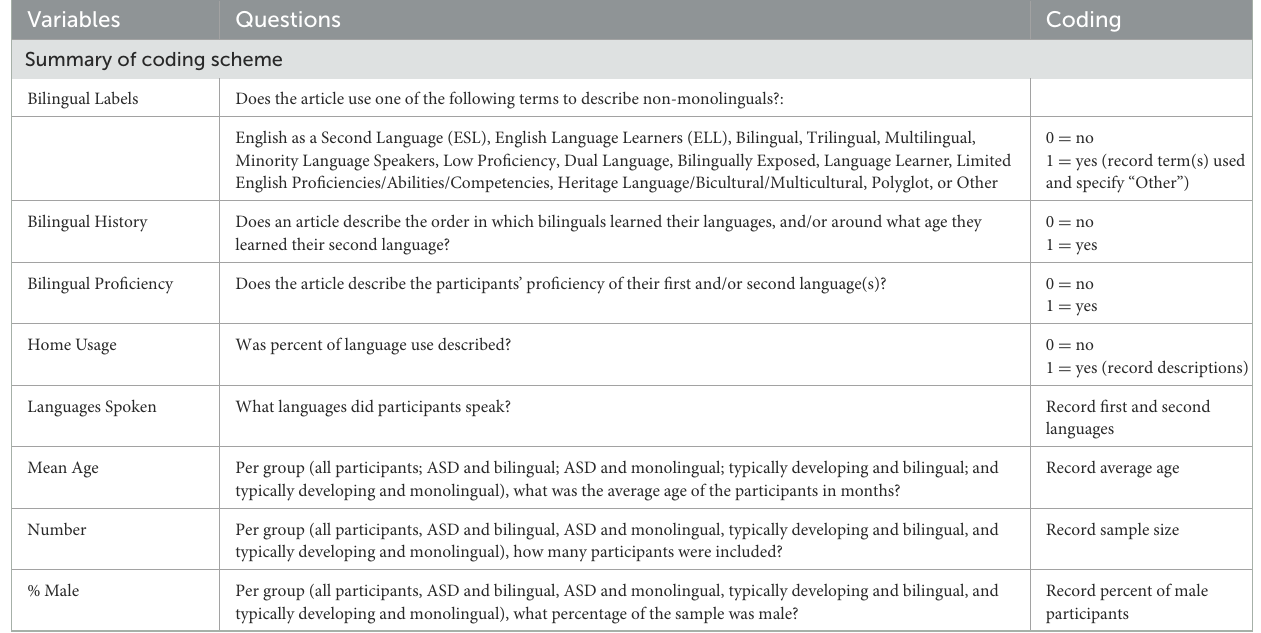
TABLE 1 Condensed version of the full coding scheme, which can be found at OSF: https://osf.io/gvn93/?view_only= 9ed9b6f9ad0d44058cc71340978324fc